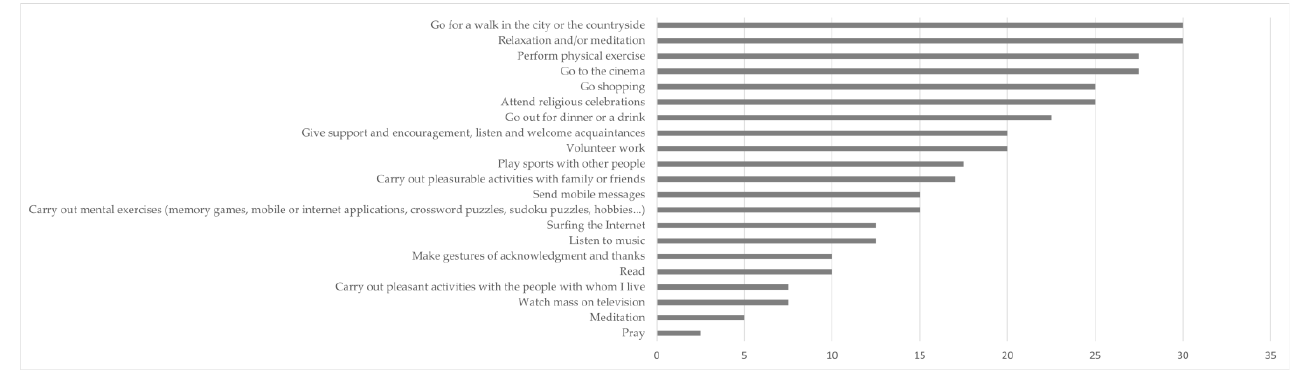
Figure 1. Percentage of people who have stopped doing the indicated activities.